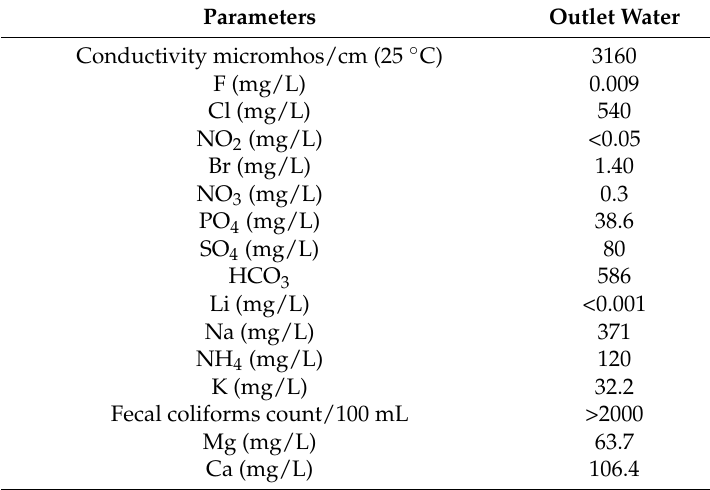
Table 7. Additional parameters obtained at the outlet of Lefkosa Central Treatment Plant between 2007 and 2008.